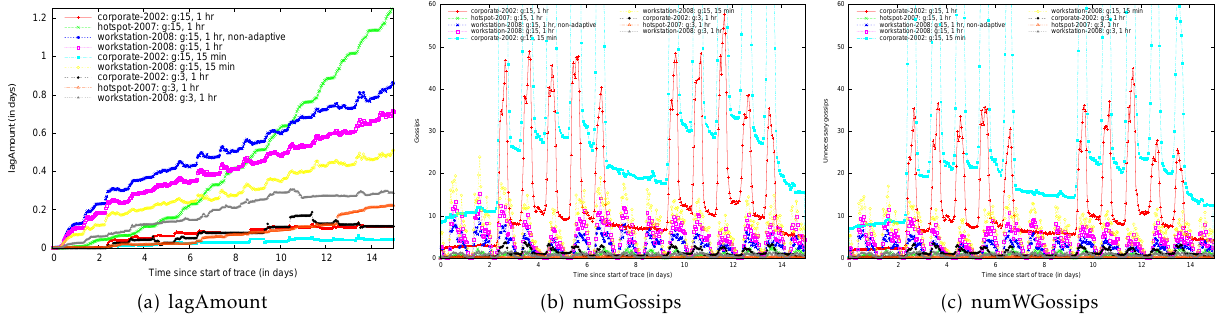
Figure 13. P2P-pull (adaptive duration by default)